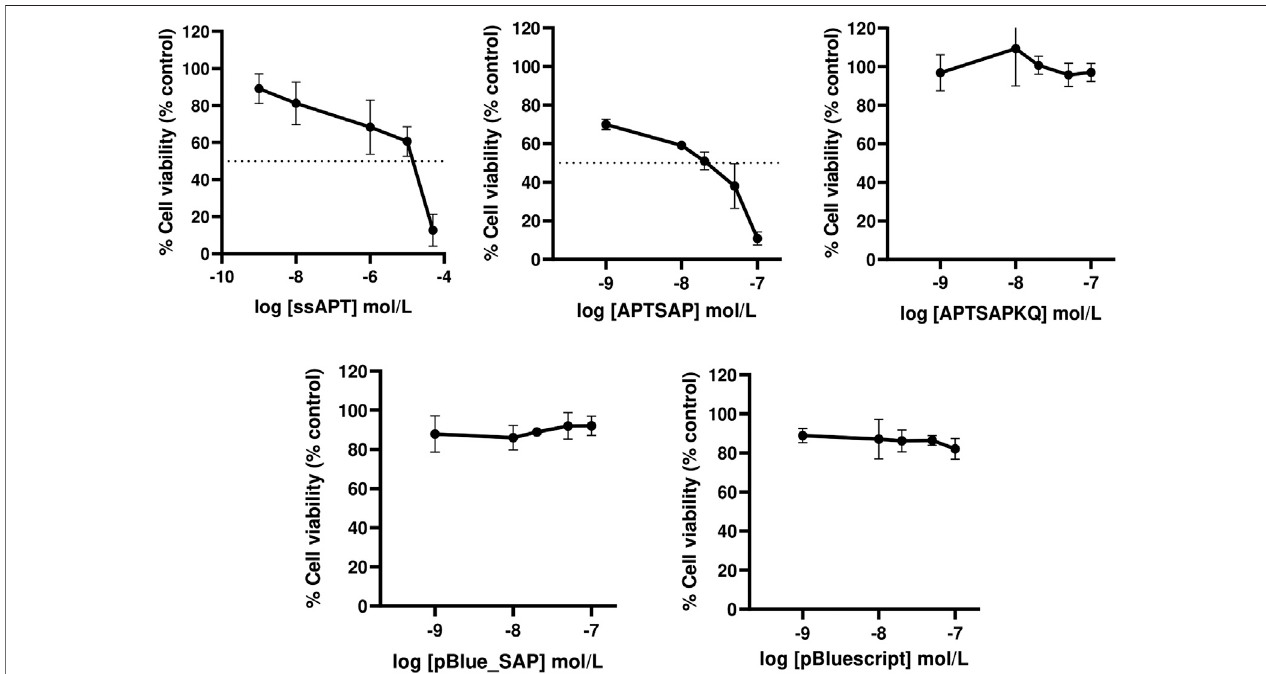
FIGURE 2 | Dose-response curves showing respectively the effects of ssAPT, APTSAP, APTSAPKQ, pBlue_SAP and pBluescript II KS (+) on U87MG cells. Cells (1.6 × 10 3 /well)wereseededin96-wellplatesina fi nalvolumeof200 µlofmedium(5%FBS)containingtheappropriateconcentrations(0,0.001,0.01,1,10,50 μ mol/L) of ssAPT or the appropriate concentrations (0, 0.001, 0.01, 0.02, 0.05 and 0.1 μ mol/L) of APTSAP, APTSAPKQ, pBlue_SAP and pBluescript II KS (+) for 96 h. All the plasmids were denatured at 95 ° C for 2 min in 10 mM Tris/HCl buffer pH 7.5 containing 100 mM NaCl and 2.5 mM KCl immediately before use. Cell viability was examined using a MTS assay and expressed as percentage of control untreated cells. ssAPT IC 50 : 4.30 × 10 − 6 ± 1.70 × 10 − 6 M (mean ± S.E.M.); APTSAP IC 50 : 1.30 × 10 − 8 ± 2.42 × 10 − 9 M (mean ± S.E.M.). The data reported are representative of a set of at least three independent experiments and are reported as mean ± SD.